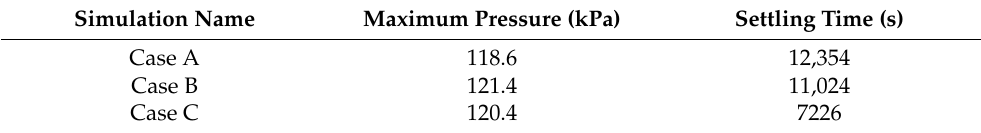
Table 4. A summary of simulation results.